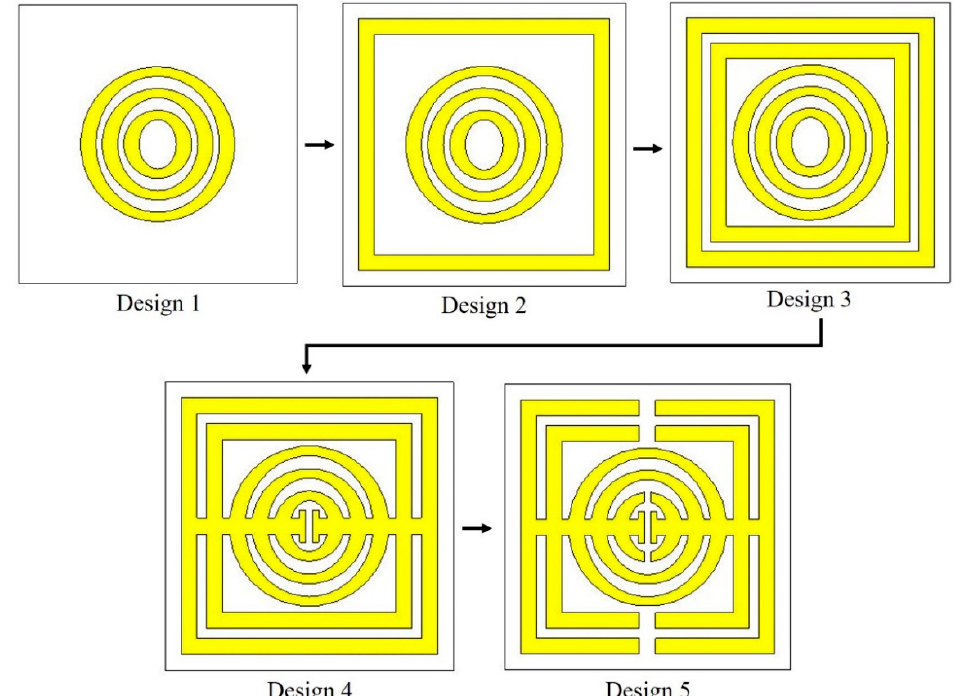
Figure 11. The steps of developing the new oval-square-shaped metamaterial structure.